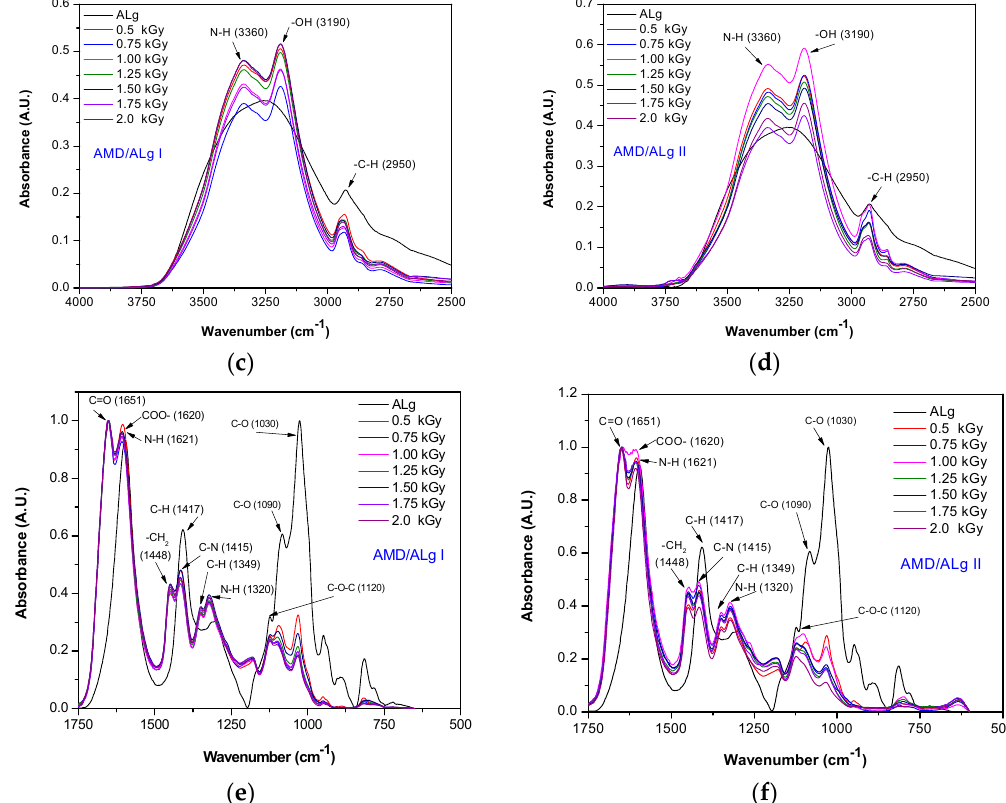
Figure 3. The FTIR spectra of AMD/ALg I ( a ) and AMD/ALg II ( b ) samples. Details of the AMD/ALg I ( c ), AMD/ALg II ( d ) spectra between 4000–2500 cm − 1 and AMD/ALg I ( e ), AMD/ALg II ( f ) spectra between 1750–500 cm − 1 .